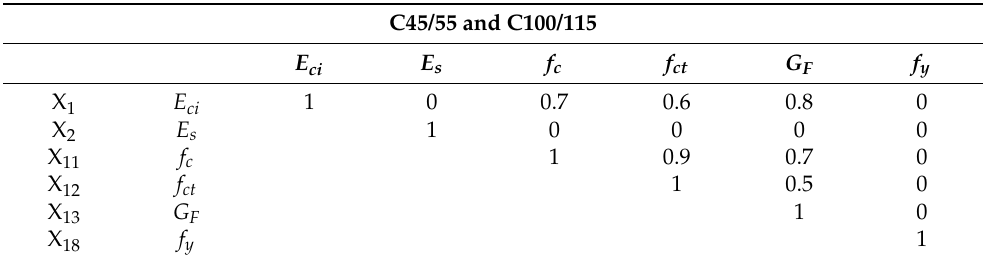
Table 5. Correlation between basic variables for EN 1992-1 Non-Linear Finite Element provisions of the slender columns made of C45/55 and of C100/115